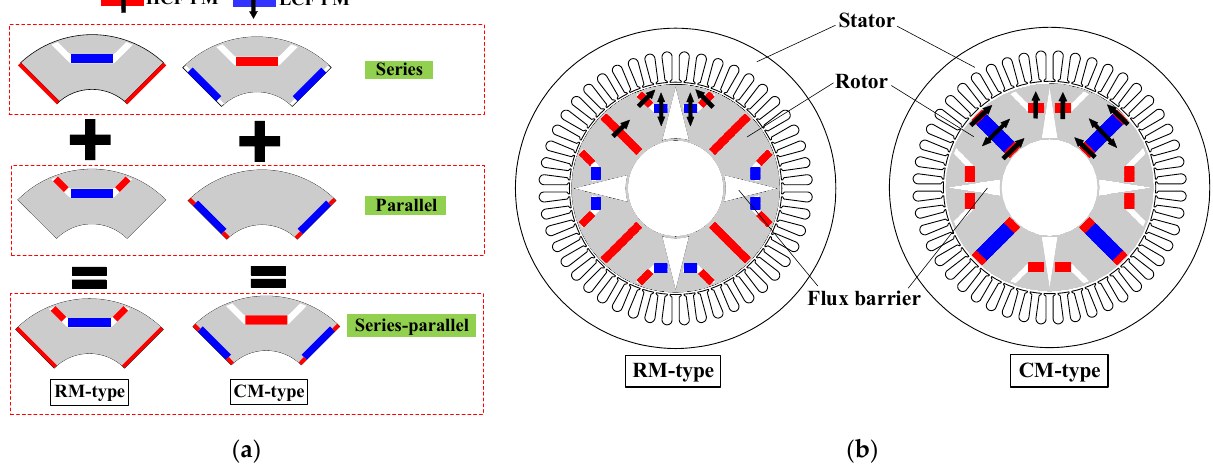
Figure 34. Hybrid PM VFM machine with series ‐ parallel coupling [89]. ( a ) Topology decomposition diagrams. ( b ) Topologies of RM ‐ type and CM ‐ type.